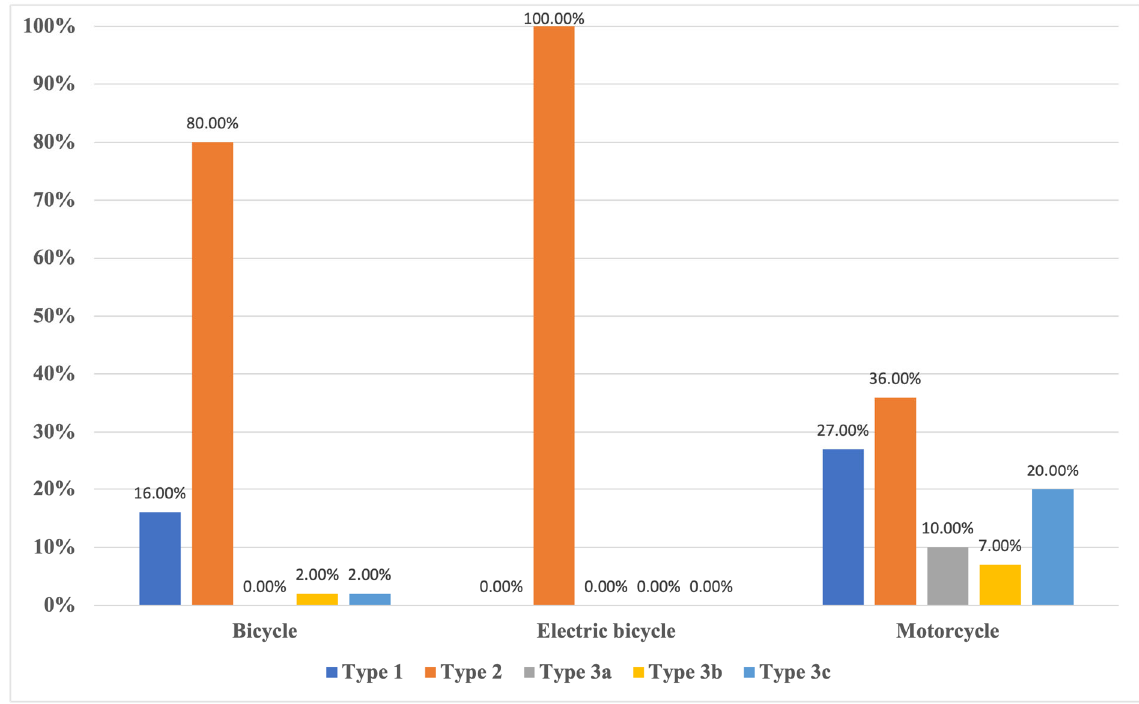
Figure 2. Distribution of open fractures stratified by vehicle group. Bars show percentages of the total number of open fractures classified according to the Gustilo — Anderson Classification (Type 1 to 3c).